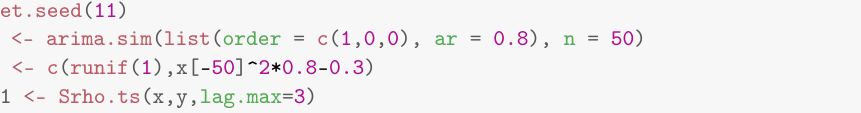
Figure 2. Cross entropy S k between X t and Y t + k ( k = − 3, . . . ,3) from Equation (9).